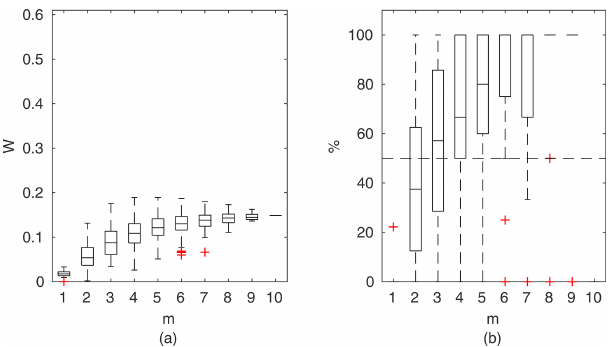
Figure 8. Manning-based DCM results for the flume data set, case 2: (a) averaged relative confidence widths W as a function of ob- servation set size m used for model identification; (b) percentage of verification points enclosed by confidence intervals (100% denotes all points within intervals, box spans over the 25% and 75% quan- tiles, the median is given with horizontal line, whiskers indicate the result extent, and cross marks are for extreme